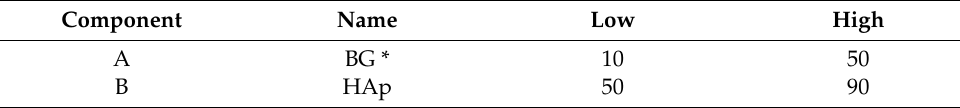
Table 1. Mixture components and their ratios in combined design.